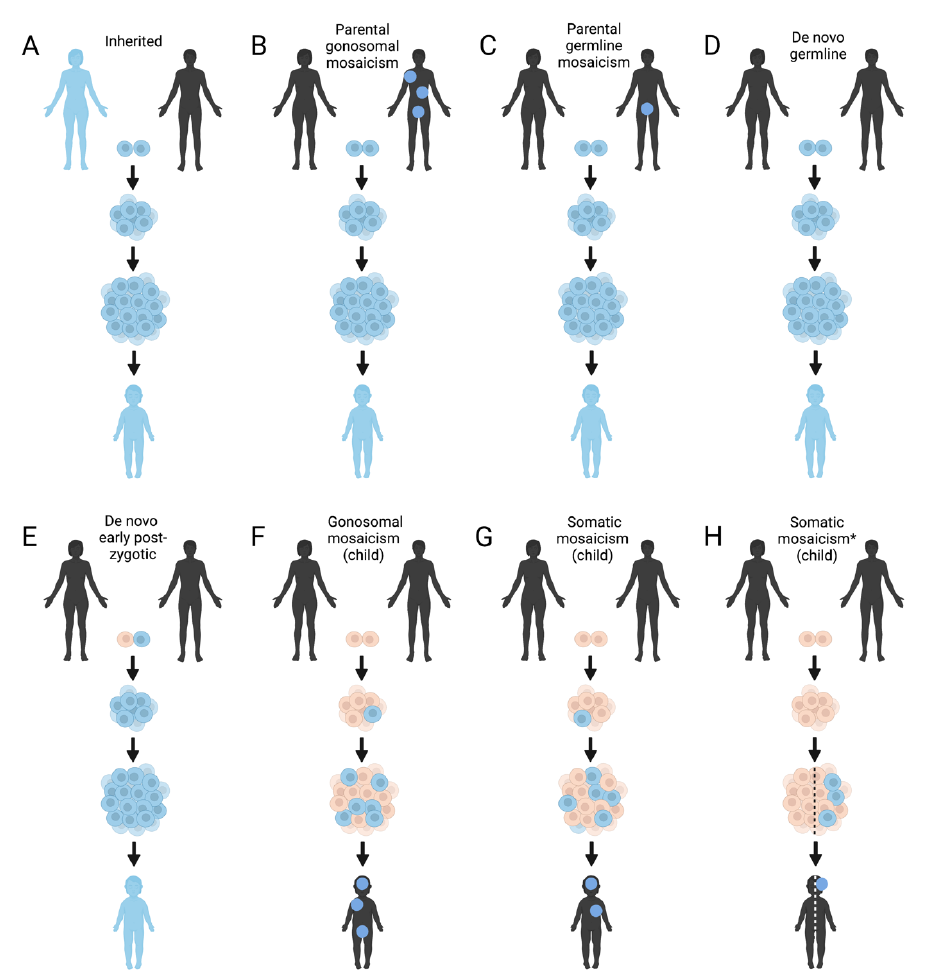
Figure 2. The different levels of mosaicism in Mendelian diseases and how they manifest. ( A ) An autosomal dominantly inherited variant that is present in all cells of the parent and child. ( B ) In gonosomal mosaicism, the variant is present within both the germline and somatic cells. The parent here with gonosomal mosaicism of a variant may express a phenotype, depending on the tissues affected. If the child inherits the variant, it will be present in all cells. Multiple children of this parent can be affected. ( C ) Germline mosaicism, also called gonadal mosaicism, only occurs in the germ cells (gametes). The parent will not be affected with disease (with the exception of, perhaps, infertility). If the child inherits the variant, it will be present in all cells. Multiple children of this parent can be affected. ( D ) With a de novo germline variant, a single germ cell is affected with the variant, and all cells of the affected child will have the variant. In this case, reoccurrence of this disorder in additional offspring is unlikely. ( E ) In cases of very early post-zygotic mutations, all cells of an affected child can be affected. This is because not all cells in the early development (before the blastocyst stage) contribute to the embryo. In this case, reoccurrence of this disorder in additional offspring is unlikely. In practice, it is difficult to distinguish between ( C – E ), and often also between ( B – E ) if the parent is asymptomatic. Most of ( C – E ) will be referred to as “de novo ” , however in B / C , there is a chance of recurrence in multiple offspring. In ( F ) a gonosomal mosaic variant is presented, which occurred de novo later in development. The phenotype of the affected child will depend on the tissues of presence; however, the variant may be transmitted to the next generation, as it is present in the germ cells. In ( G ) a somatic mosaic variant is presented. The phenotype of the affected child will depend on the tissues of presence; however, the variant will not be transmitted to the next generation, as it is not present in the germ cells. The same is presented in ( H ). However, in this case, the variant arose after left-right determination, affecting only tissue(s) on one side of the body. * Also possible for gonosomal mosaicism. This figure was created with BioRender.com (accessed on 5 February